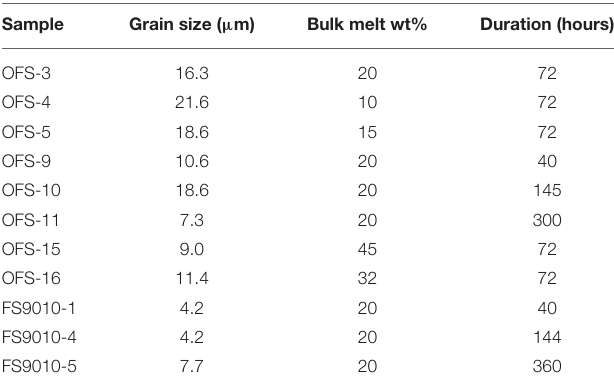
TABLE 1 | Summary of experimental conditions and grain size of the synthetic